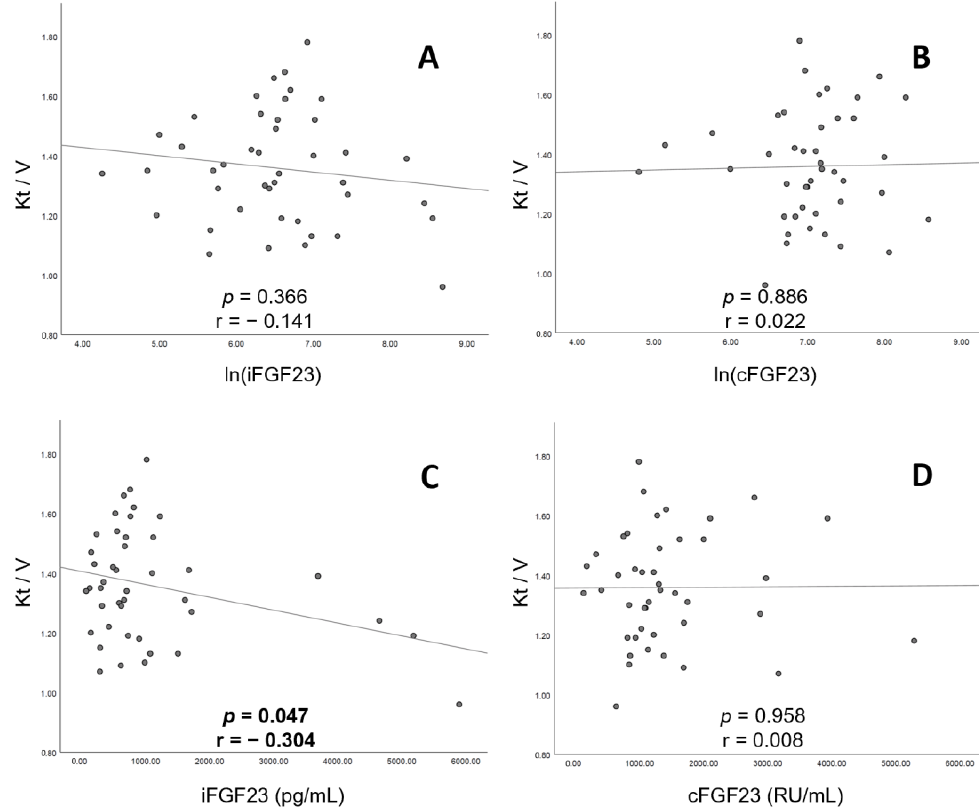
Figure 5. Correlations between Kt/V levels and ( A ) ln(iFGF23), ( B ) ln(cFGF23), ( C ) cFGF23 levels and ( D ) iFGF23 levels. The regression lines in the figure are based on the least mean squares method. Abbreviations: ln, natural log transformation; iFGF23, intact fibroblast growth factor 23; cFGF23, c-terminal fibroblast growth factor 23; ln, natural log transformation; Kt/V, urea kinetic.